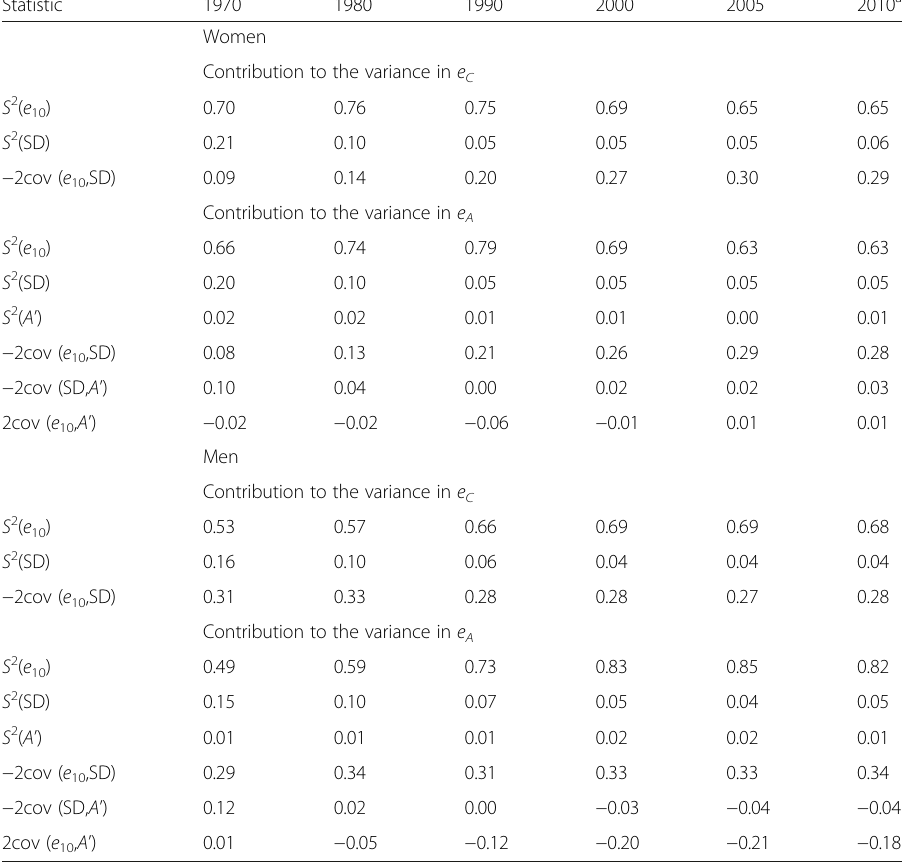
Table 2 Contribution (in percent) to the variance in the ELL summary measures e C and e A across 35 developed countries of the different components constituting the summary measures (dispersion SD and skewness A ’ , and their interrelations), by sex, and for selected years from 1970 to